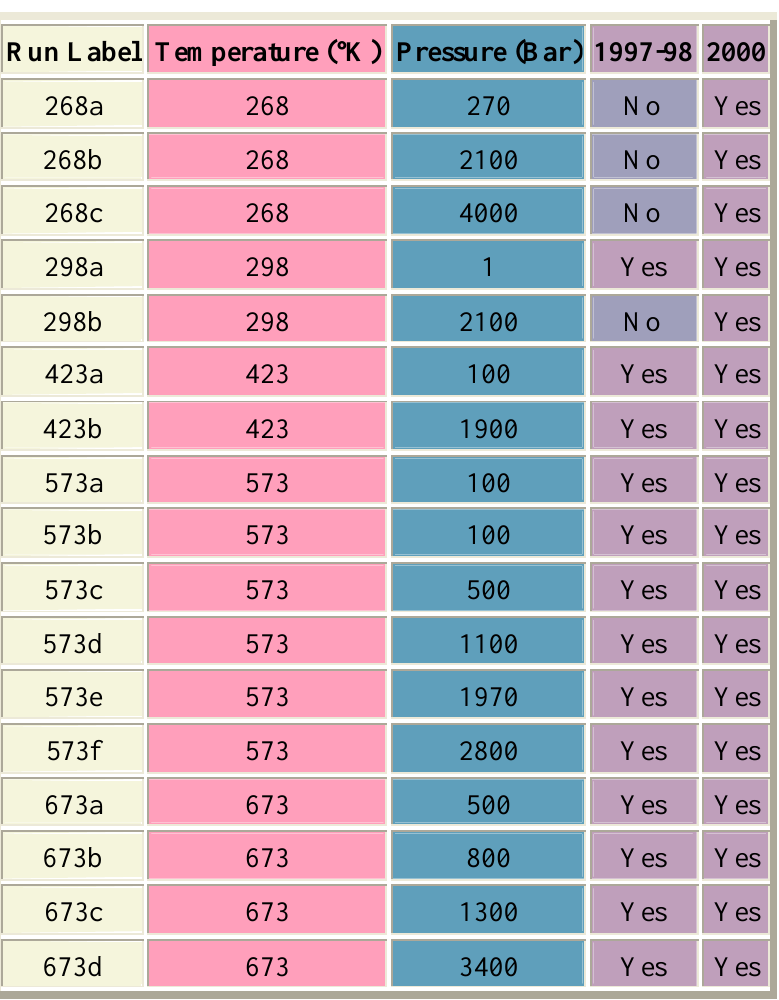
Run Label Temperature (°K) Pressure (Bar) 1997-98